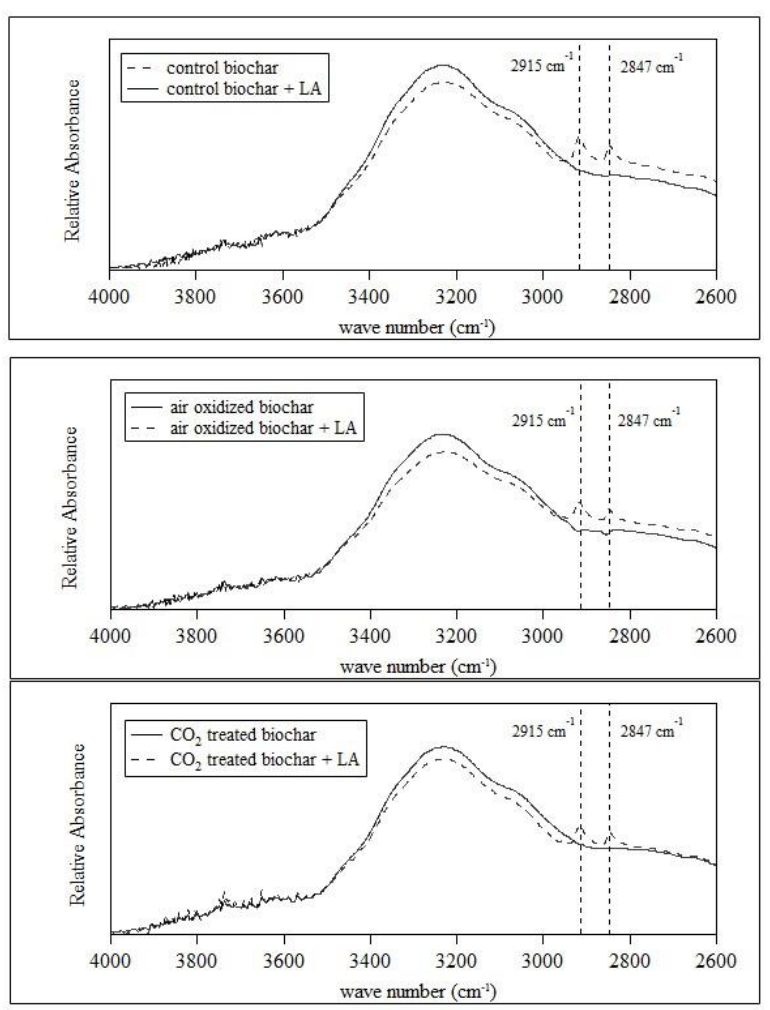
Figure 2. FTIR spectra for LA-coated vs. uncoated biochar samples showing the presence of LA by the peaks at 2847 and 2915 cm − 1 .